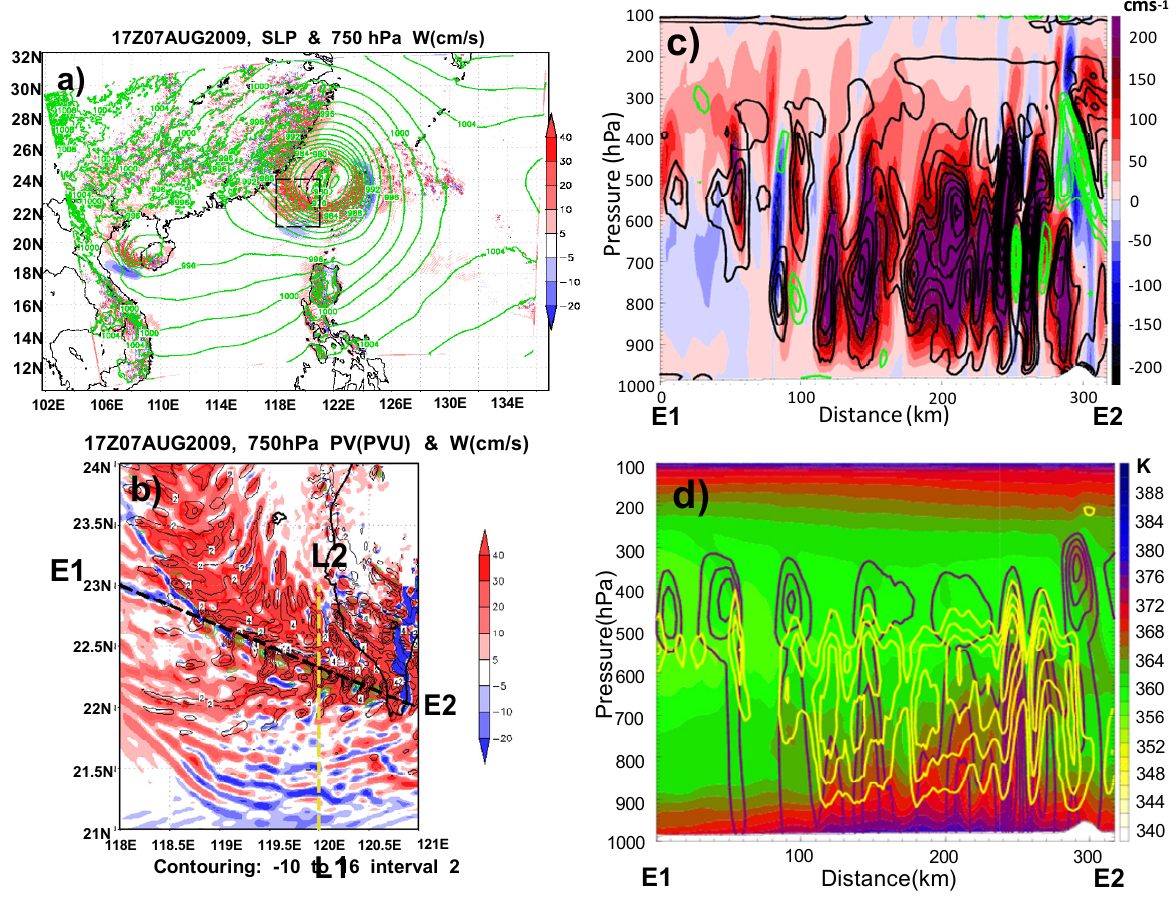
118E 118.5E 119E 119.5E 120E 120.5E 121E L1 Contouring: -10 to 16 interval 2 Figure 10 Fig. 10. (a) Simulation of horizontal distribution of surface pressure (contour) and vertical velocity (shaded) at 750hPa at 17:00UTC 7 August 2009. (b) Same as Fig. 8b but for 17:00UTC 7 August (c) The cross-section distribution along E1–E2 in (b) for vertical veloc- ity (shaded) and potential velocity (positive in black and negative in green, interval 2PVU) (d) Same as (c) but for equivalent potential temperature (shaded), Total precipitation mixing ratio (contour in pink) and total cloud mixing ratio (contour in